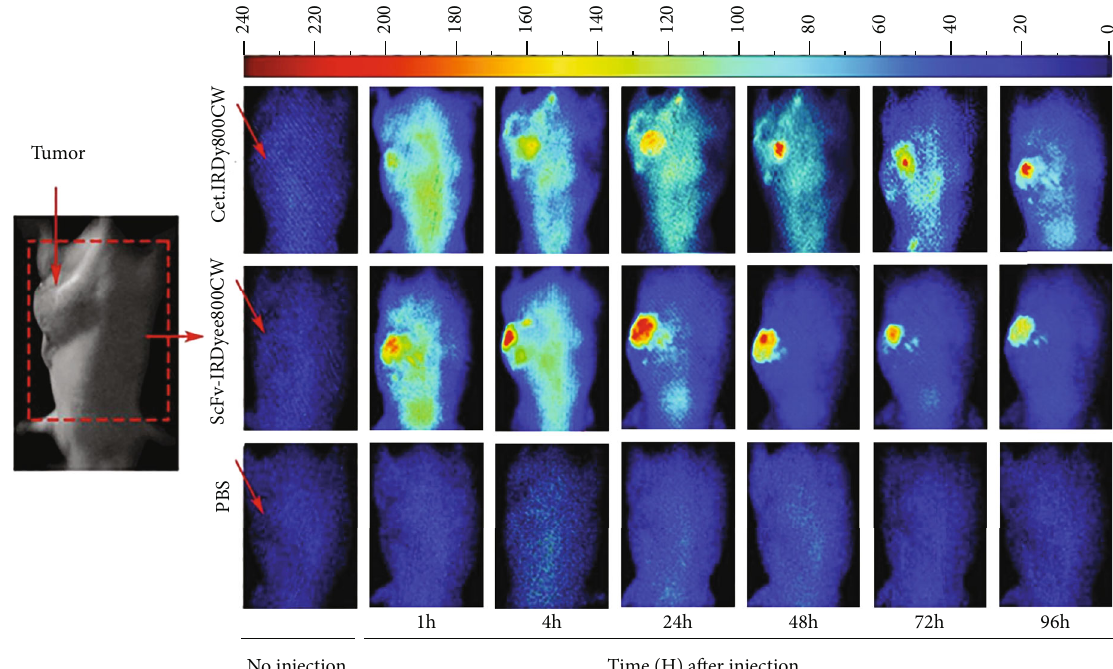
Figure 4: NIR fl uorescence images of cet.Hum.scFv-IRDye800CW and cetuximab-IRDye800CW conjugates in mice bearing A-431 tumor xenografts. Images were obtained at noninjection and at 1, 4, 24, 48, 72, and 96 hours postinjection of 100 μ L for the cet.Hum.scFv- IRDye800CW and cetuximab-IRDye800CW (75 μ g). Scale bar changes are shown on the top. The degree of labeling or D/P ratio of cet.Hum.scFv-IRDye800CW and cetuximab-IRDye800CW was 1.983 and 2.128, respectively.